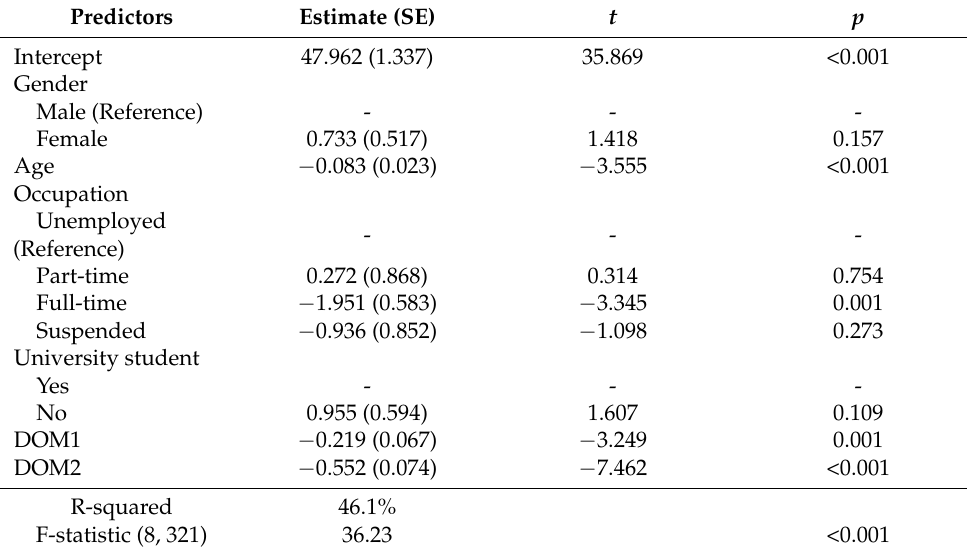
Table 5. Stepwise Linear Regression Model for Perceived Stress (PSS).